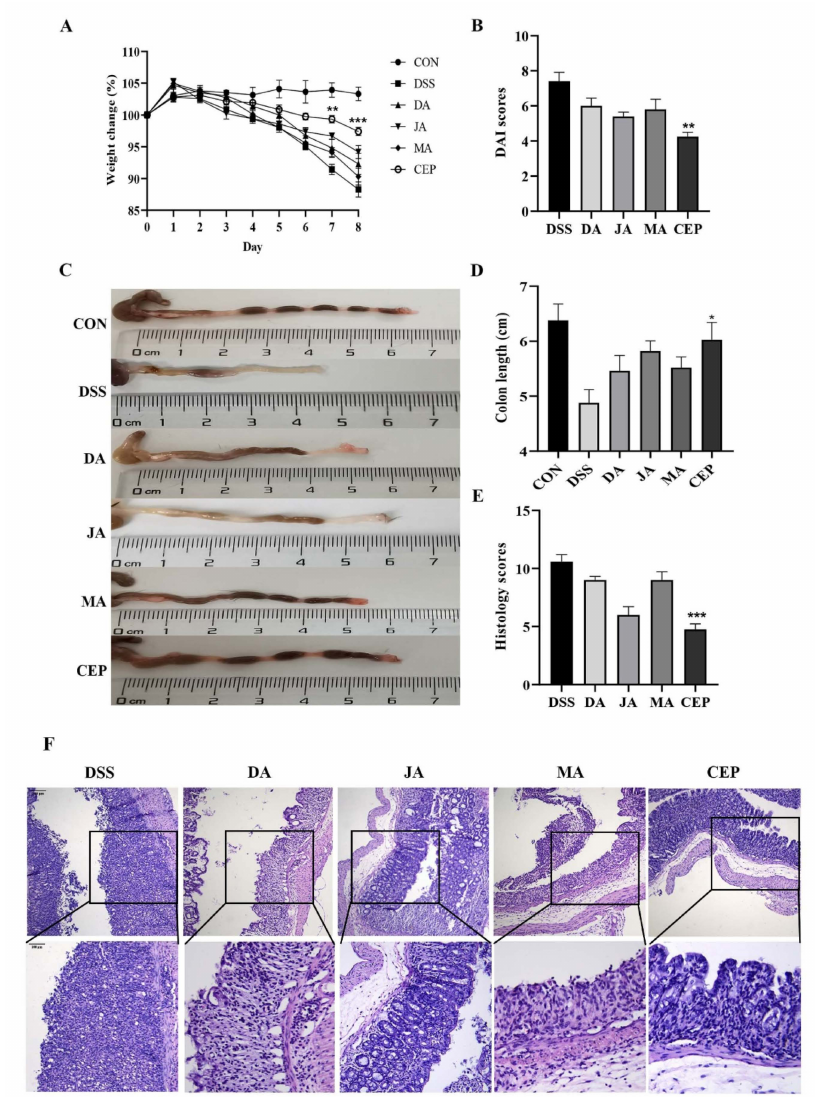
Figure 1. CEP protects the mice from DSS-induced UC. ( A ) The percentage of body weight changes of mice during drug administration; The* represents significant difference between the DSS and CEP group and ( B ) the DAI score; ( C ) representative photographs of the colon; ( D ) the colon length; ( E ) the histology score; values are presented as the mean ± standard error of the mean (SEM); n = 5 in each group; * p < 0.05, ** p < 0.01, *** p < 0.001. ( F ) H&E staining of mice colon tissue, the photos were observed by confocal laser-scanning microscope, 100 × , 200 ×